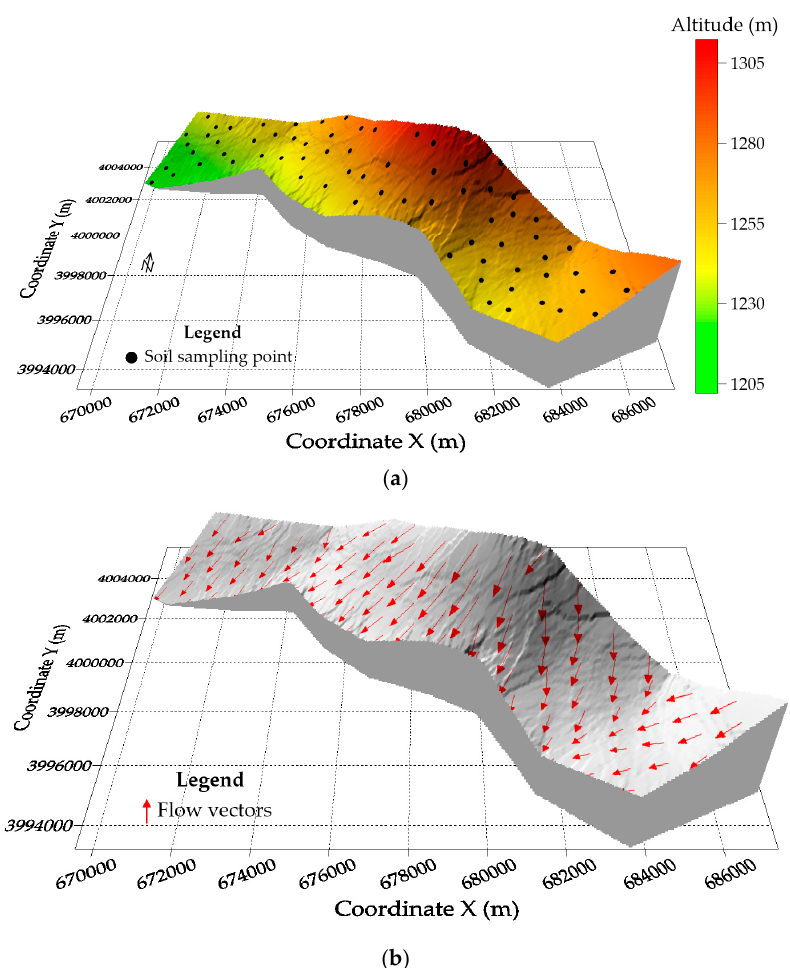
Figure 2. Thematic map representative of the elevation and sampling points grid ( a ) and flow vectors ( b